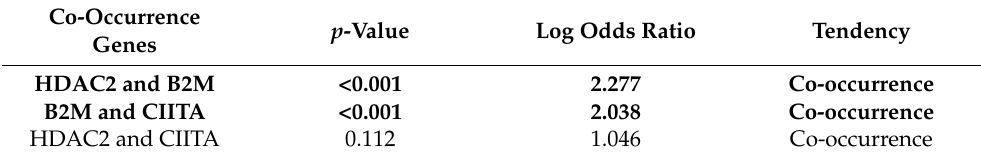
Table 1. Co-occurrence analysis of alterations in HDAC2 , CIITA , and BM2 genes.